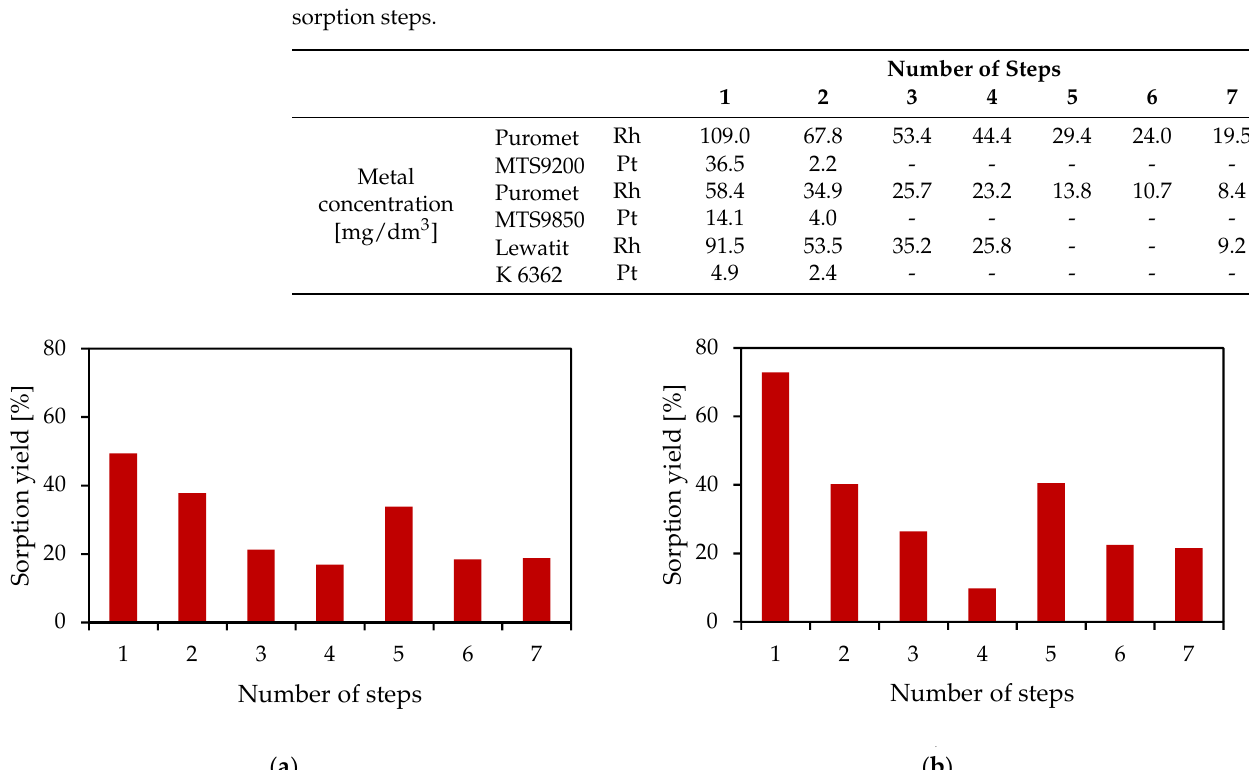
Figure 5. The dependence of the sorption yields of rhodium on the number of ion-exchange process steps for ( a ) Puromet MTS9200, ( b ) Puromet MTS9850.